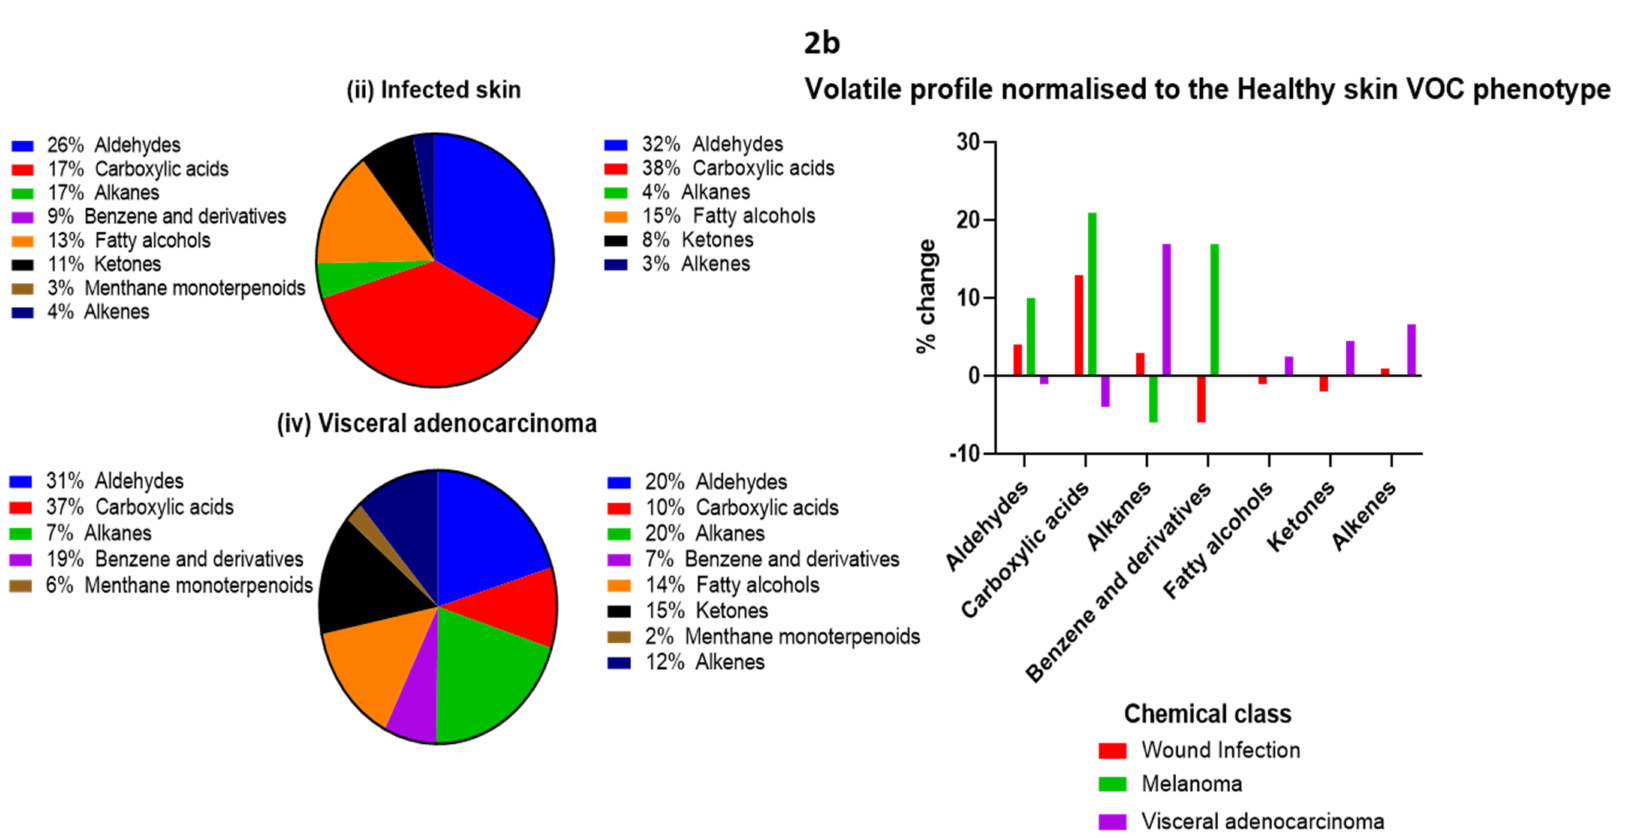
Figure 2. The composition of the human skin volatolome in health and disease. ( a ) The composition of the skin volatolome from the top eight chemical classes from (i) healthy skin, (ii) infected skin, (iii) participants with melanoma, and (iv) patients with mixed visceral adenocarcinoma. ( b ) Percentage change in the skin VOC profile normalised to the healthy skin profile in a range of disease